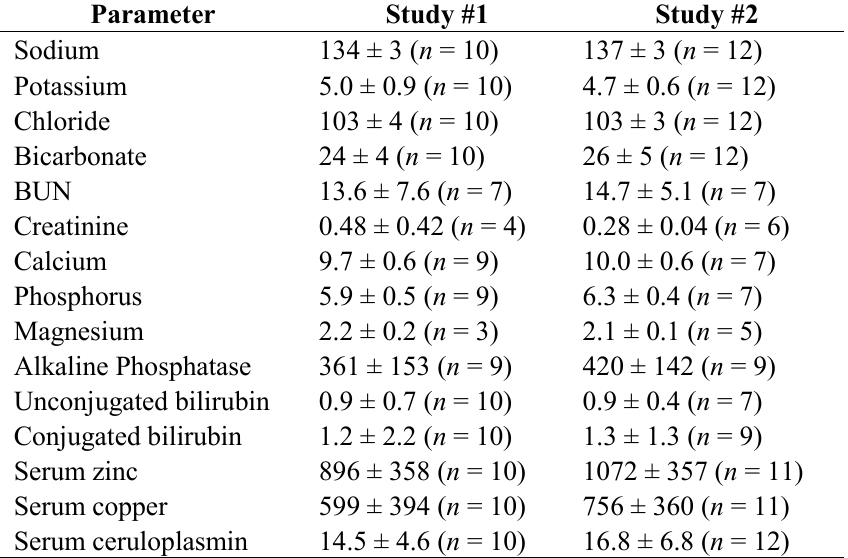
Table 2. Biochemical data at the time of